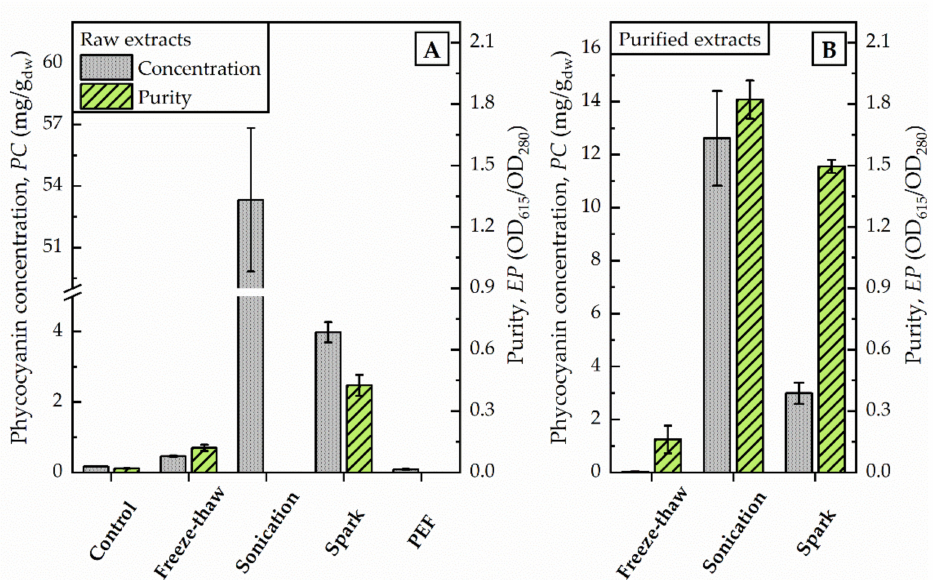
Figure 2. Photometric determination of raw extracts ( A ) and selected purified extracts ( B ) after different disintegration methods. Phycocyanin concentration (PC) and purity (EP) were calculated as given in Equations (1) and (2) regarding to Bennett and Bogorad, and Abalde et al., respectively. PC is given in mg/g dried weight (dw) of biomass (100